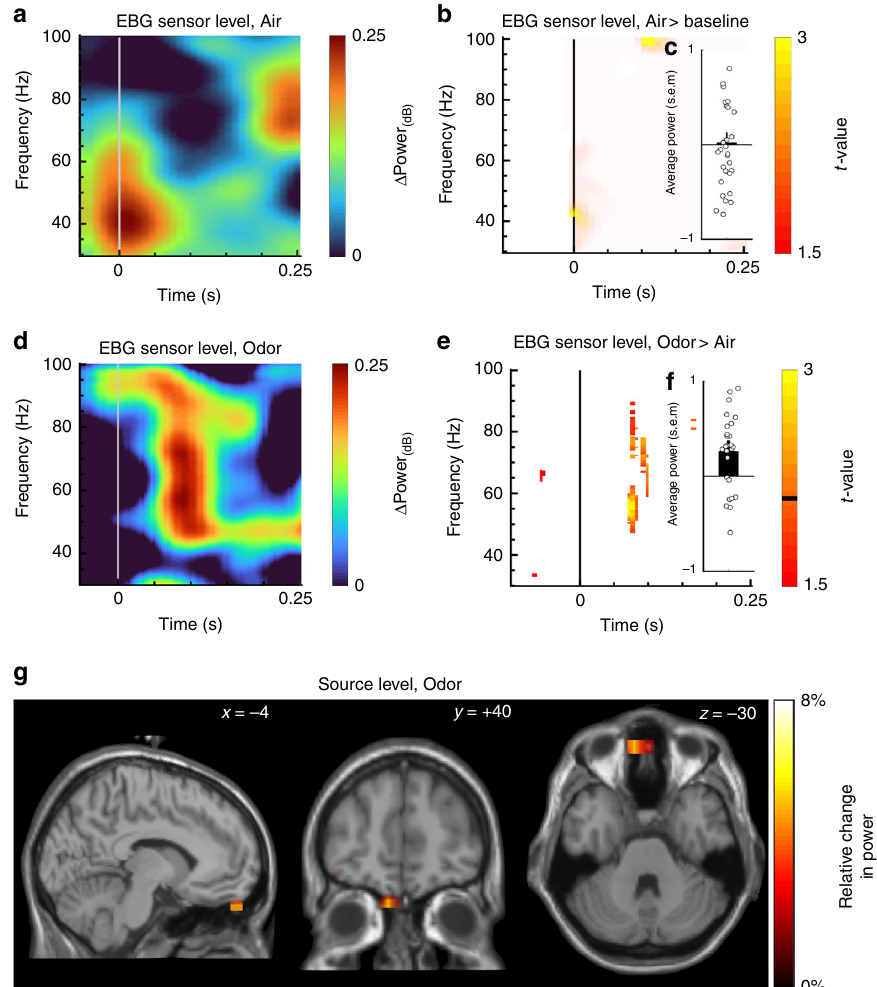
Fig. 2 Localization of odor-evoked response in sensor and source space ( n = 29). a Sensor time-frequency decomposition of difference in power for Air vs. Baseline condition for the EBG electrodes. b T-statistics derived from 1000 Monte Carlo permutations demonstrating no change in power for inhalation of Air only condition for the EBG electrodes. c Averaged power change for Air across 100 – 125 ms with standard error of the mean (s.e.m). Circles show individual values. d Sensor time-frequency decomposition for Odor against Air conditions. e T-statistics derived from 1000 Monte Carlo permutations contrasting Odor with Air conditions ( p < .01). Orange color marks signi fi cant change in power for Odor against Air and the black horizontal line on the color-bar marks the threshold for displayed t -values. f Averaged power change for Odor condition across 100 – 125 ms with s.e.m. Circles show individual values. g Reconstructed sources of the olfactory evoked synchronization indicating olfactory bulb as the source. Color bars denote relative change in power and x , y , z coordinates in fi gures indicate coordinates of slice in Talairach space according to the MNI stereotactile reference